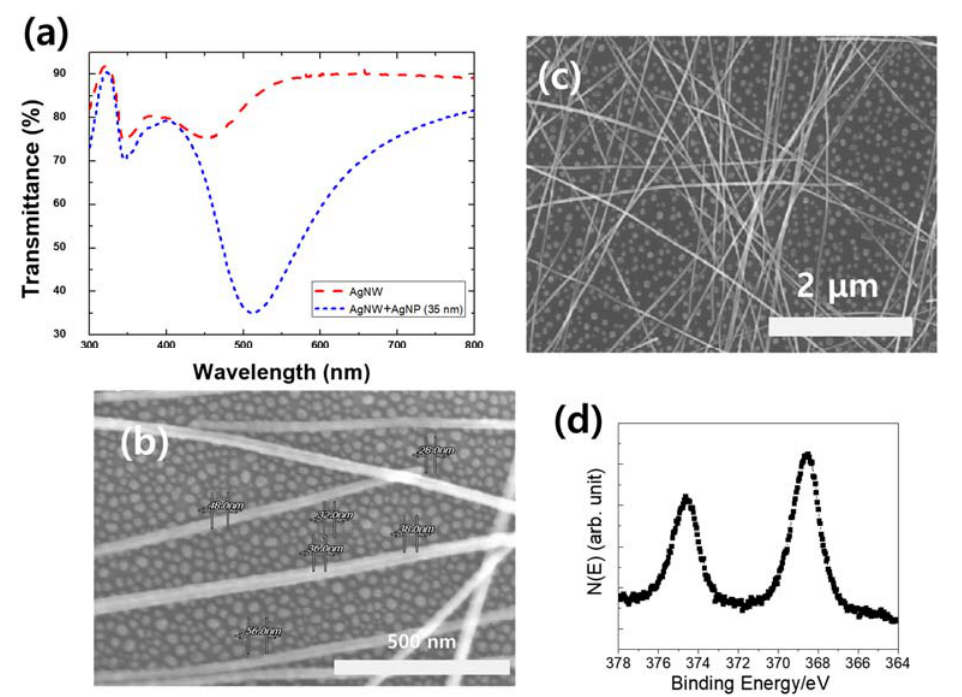
Figure 2. ( a ) Transmittance of Ag NW and Ag NW/NP TCEs for different NP sizes. FE-SEM images of Ag NW/NP TCEs with NP size with ( b ) 2 µm scale bar and ( c ) 500 nm scale bar, ( d ) XPS spectrum of Ag NW/NP TCE.